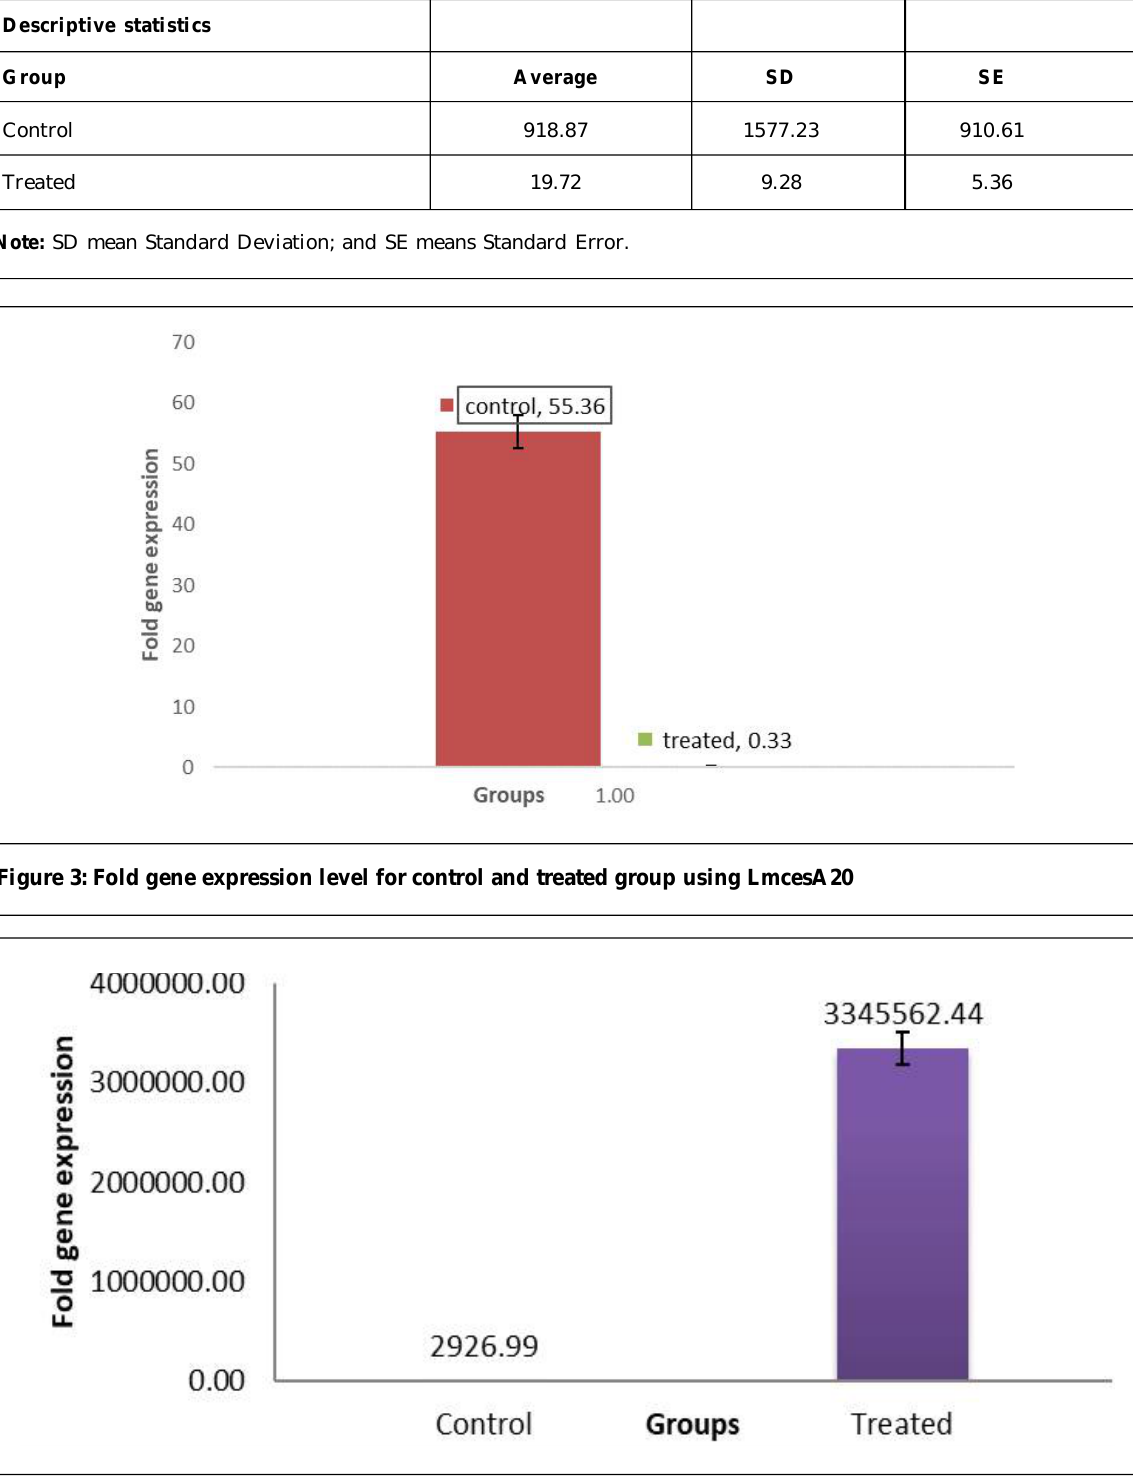
Figure 4: Fold gene expression level for control and treated groups using